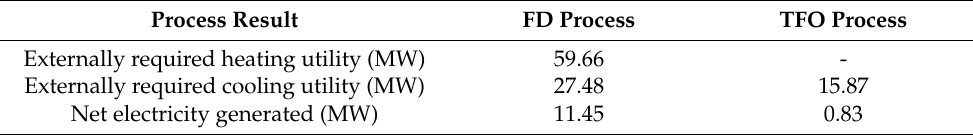
Table 4. External utility requirements of the conversion processes, assuming full heat